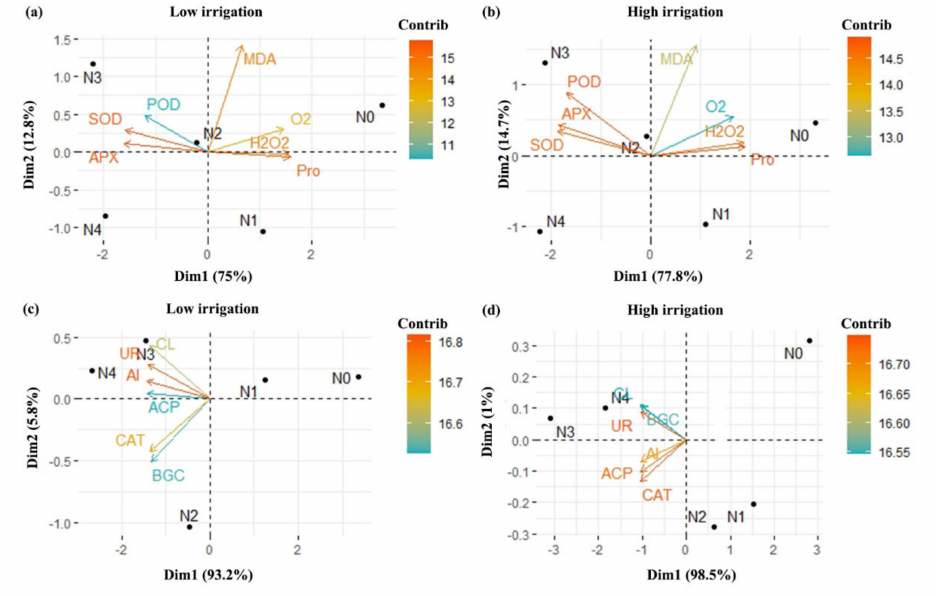
Figure 8. Principal component analysis (PCA) indicates that the largest separation among antioxidant enzymes is the spatial distribution of irrigation water (Dim1) and the second largest source of variation is nitrogen fertilizer (Dim2). Plant enzymes activities in low irrigation ( a ), plant enzymes activities in high irrigation ( b ), soil enzymes activities in low irrigation ( c ), and soil enzymes activities in low irrigation ( d